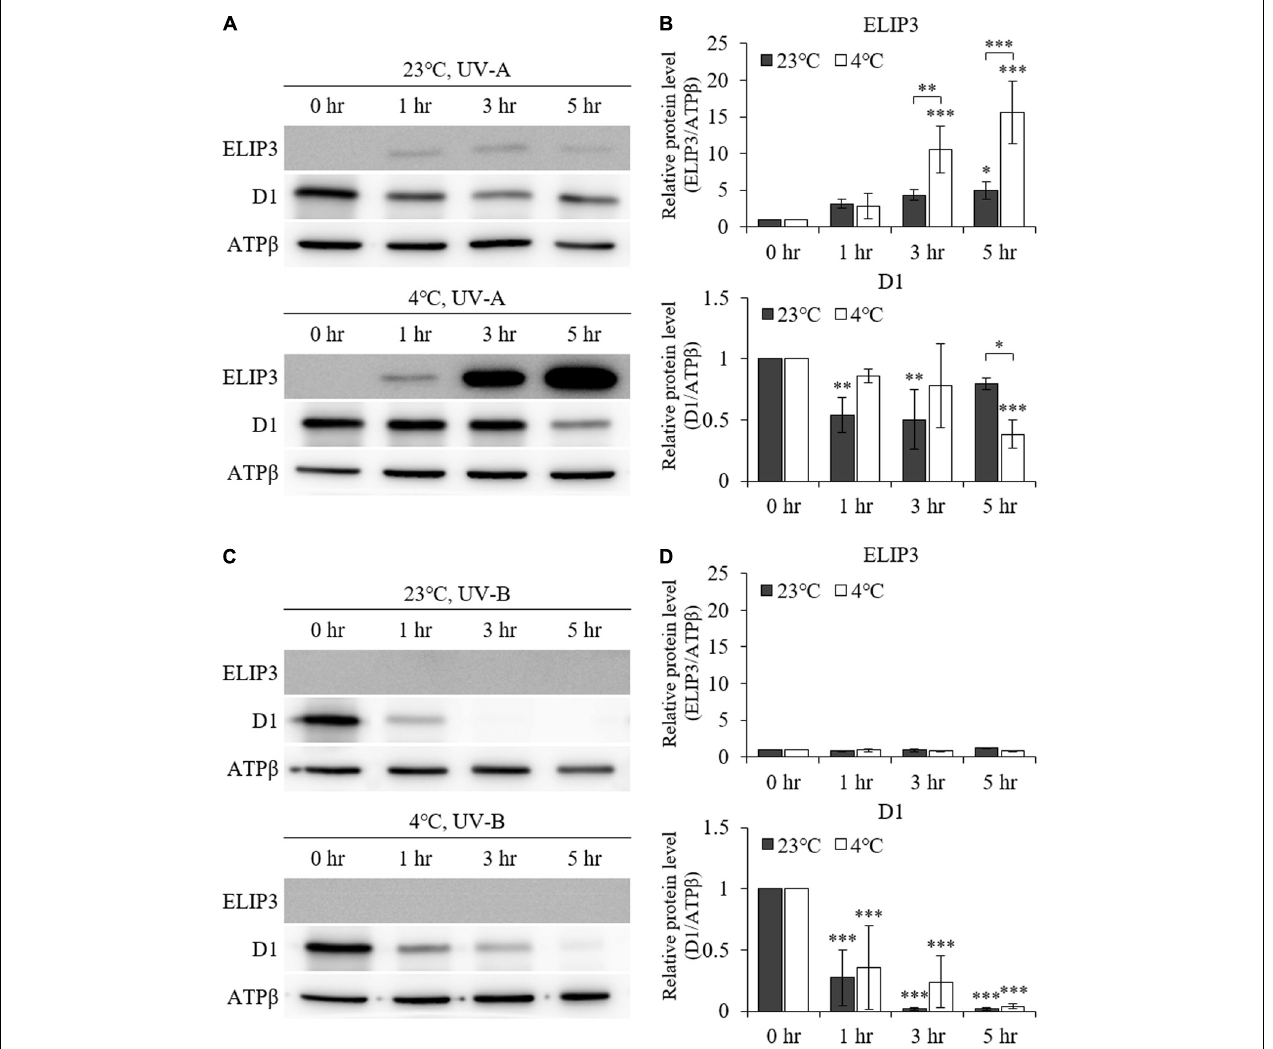
FIGURE 3 | Western blot analysis under UV irradiation. (A) Accumulation of ELIP3 and D1 in UV–A irradiation. (B) Densitometry of western blots in (A) . Data are expressed as mean ± SD (two-way ANOVA with Bonferroni’s multiple comparisons test, n = 3). (C) Accumulation of ELIP3 and D1 in UV-B irradiation. (D) Densitometry of western blots in (C) . Data are expressed as mean ± SD (two-way ANOVA with Bonferroni’s multiple comparisons test, n = 3). ATP β was used as a loading control. ∗ P < 0.05, ∗∗ P < 0.01, ∗∗∗ P < 0.001.